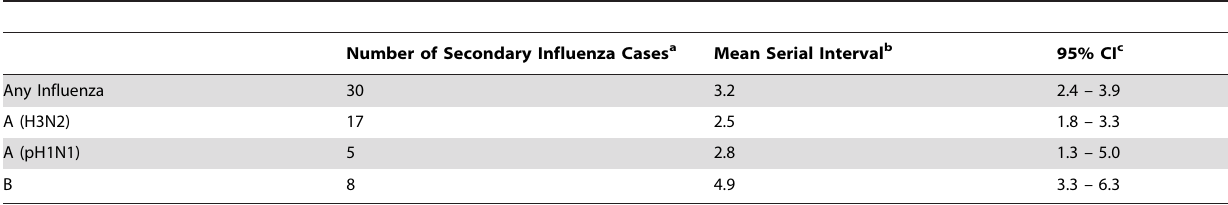
Table 4. The serial interval for cases of household influenza transmission overall and by influenza type and subtype: the Household Influenza Vaccine Effectiveness (HIVE) study, Ann Arbor Michigan, 2010-2011 influenza